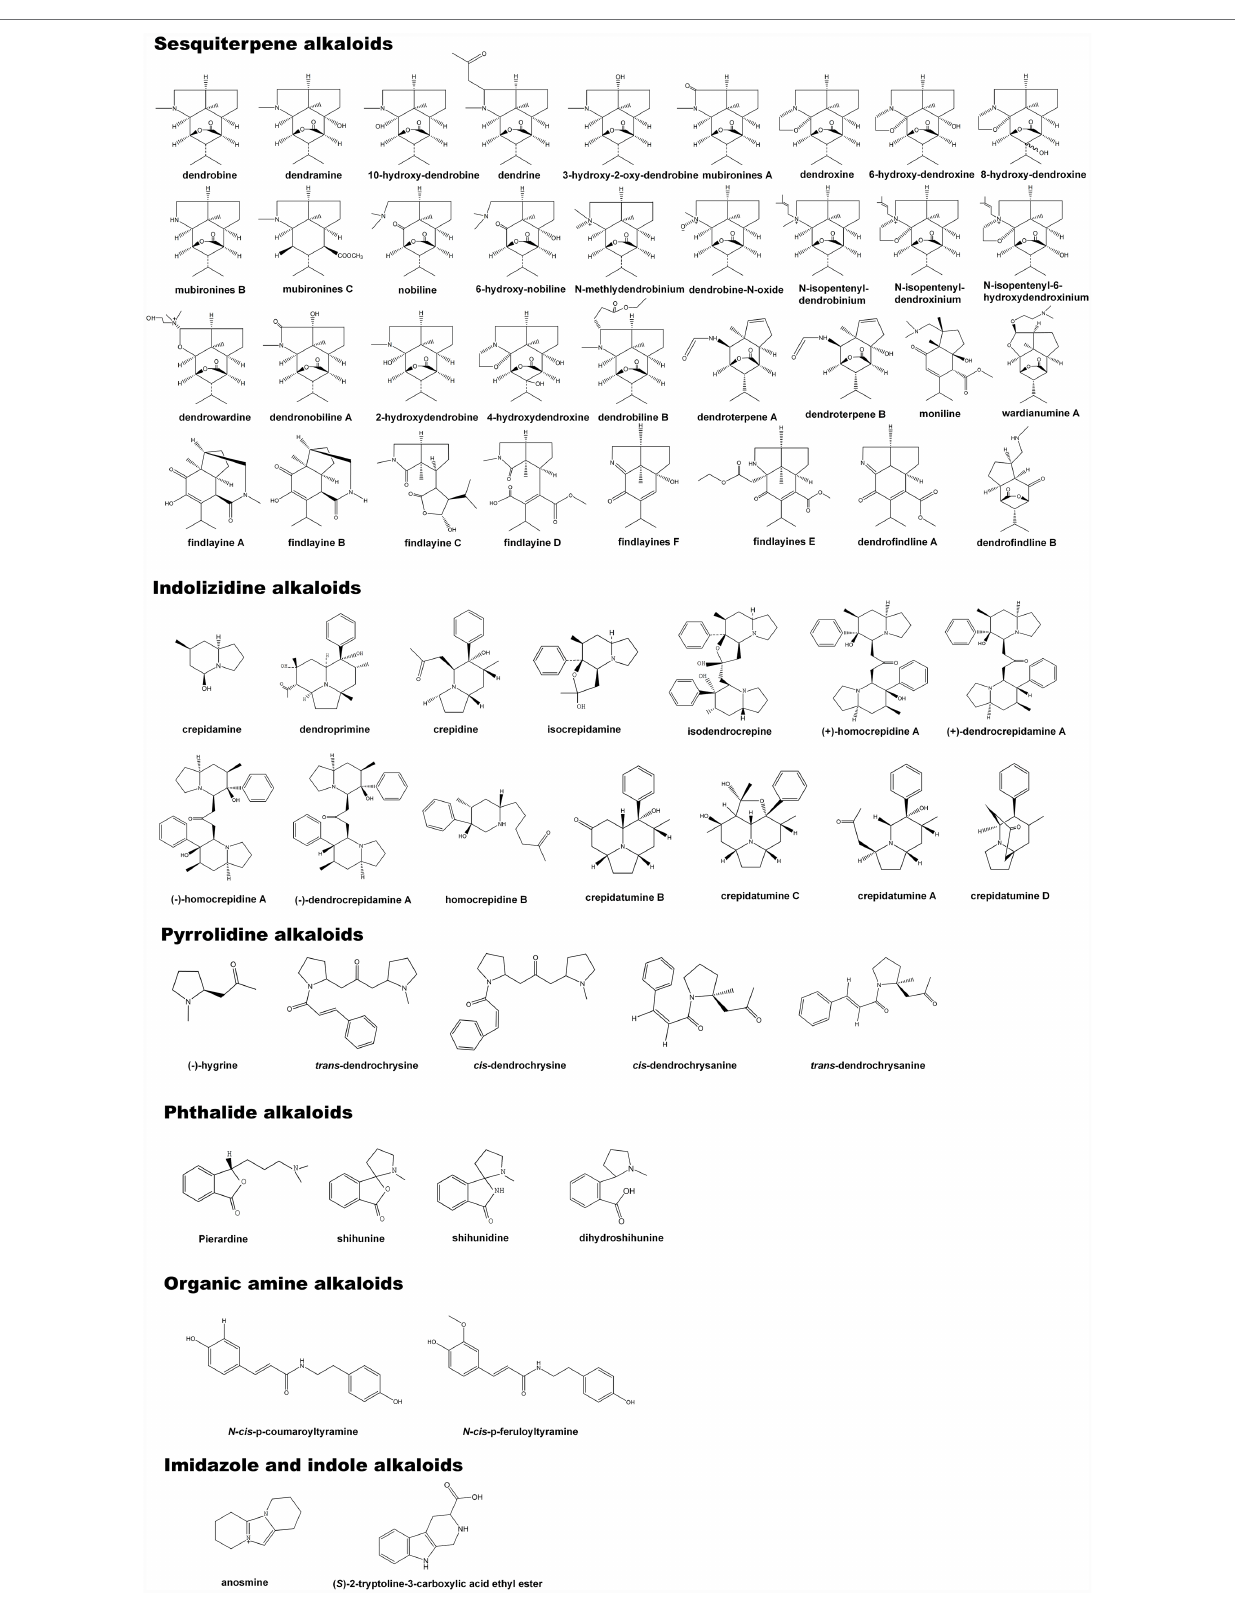
FIGURE 1 | The composition and chemical structure of Dendrobium